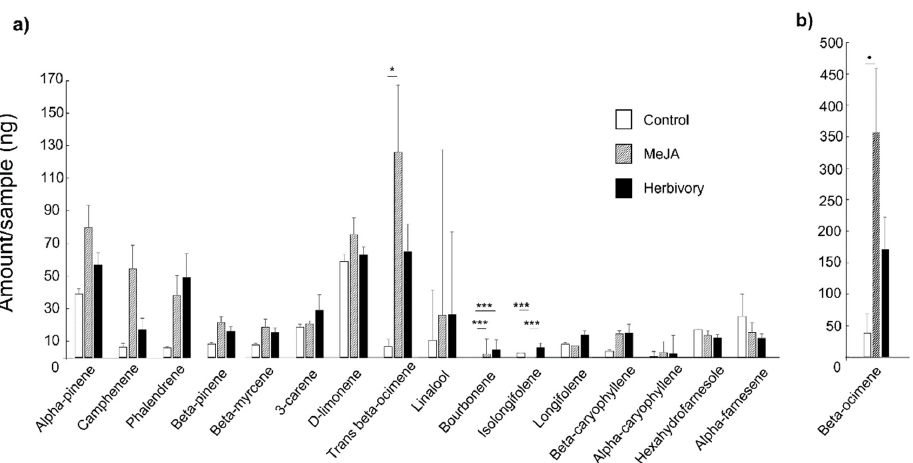
Figure 3. Mean change in the VOCs emission between MeJA-treated, herbivore-induced, and Control trees of Pyrenean oak. The x-axes show the individual compounds, and y-axes show the relative amount (ng; in a and b with different y-axis scales) of emitted VOCs. MeJA-treated and herbivore- induced trees released significantly higher amounts of Bourbonene ( a ) compared to control trees. MeJA-treated trees emitted more Trans- β -Ocimene and β -Ocimene ( b ) than the control trees. MeJA- treated trees did not produce Isolongifolen in contrast to the control and herbivory-infested trees ( a ). Treatments with significantly different amounts of volatiles are marked by asterisks (*** p < 0.001, * p < 0.05, • p = 0.05); results of chisq